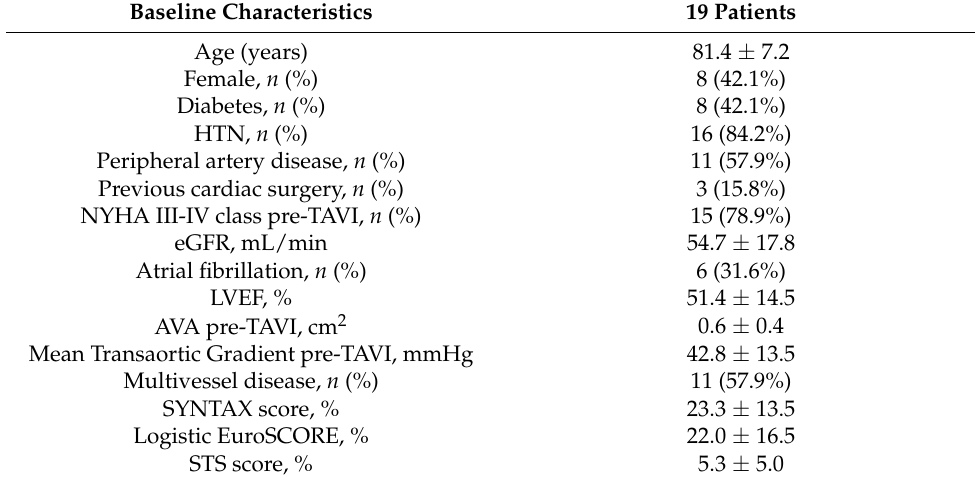
Table 1. Baseline